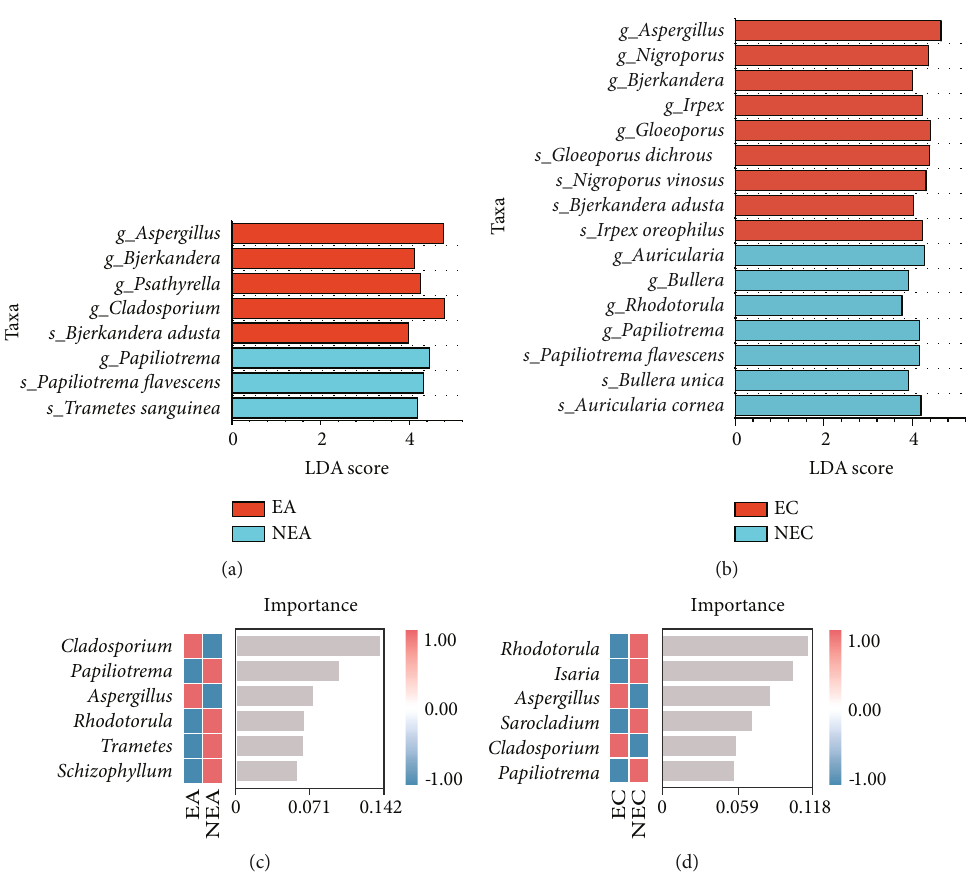
Figure 3: Di ff erential taxa of fungi between eosinophilic and noneosinophilic in fl ammatory phenotypes. At genus and species levels, the LEfSe analysis between (a) EA vs. NEA and (b) EC vs. NEC. The LDA threshold was set at 3.0, and taxa with relative abundance less than 0.5% were fi ltered out. The fungal genera predicted by random forest analysis for classifying (c) asthma and (d) COPD subjects into eosinophilic and noneosinophilic in fl ammatory phenotypes. Random forest models were established against a 10-fold